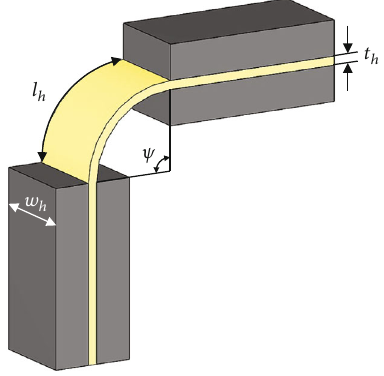
Figure 11: Schematic of the fl exible wing